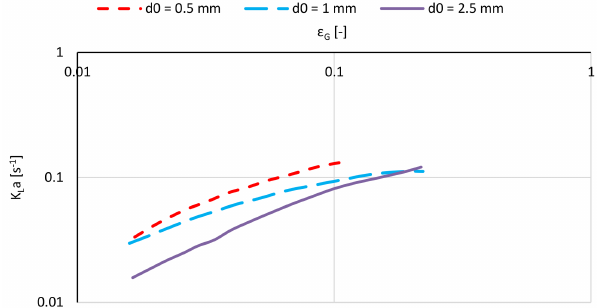
Figure 29. Influence of the gas sparger openings on k L a —data taken from Koide et al. [138]. Column diameter. Deckwer and Schumpe [287] found that the dependence of k L a on the column diameter exists only for column diameters smaller than 0.6 m. Conversely, Akita and Yoshida [47] (Figures 30 and 31) found that the mass transfer coefficient is related to the bubble column diameter up to a diameter of approximately 0.15 m, which is in agreement with the “ large diameter ” concept described in Equation (1) and the experimental results of Vandu and Krishna [304] (Figure 32).